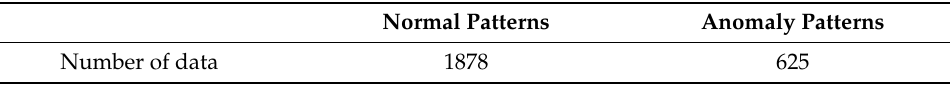
Table 3. The number of engine clutch engagement/disengagement patterns for model training and test (after the copy of anomaly patterns).